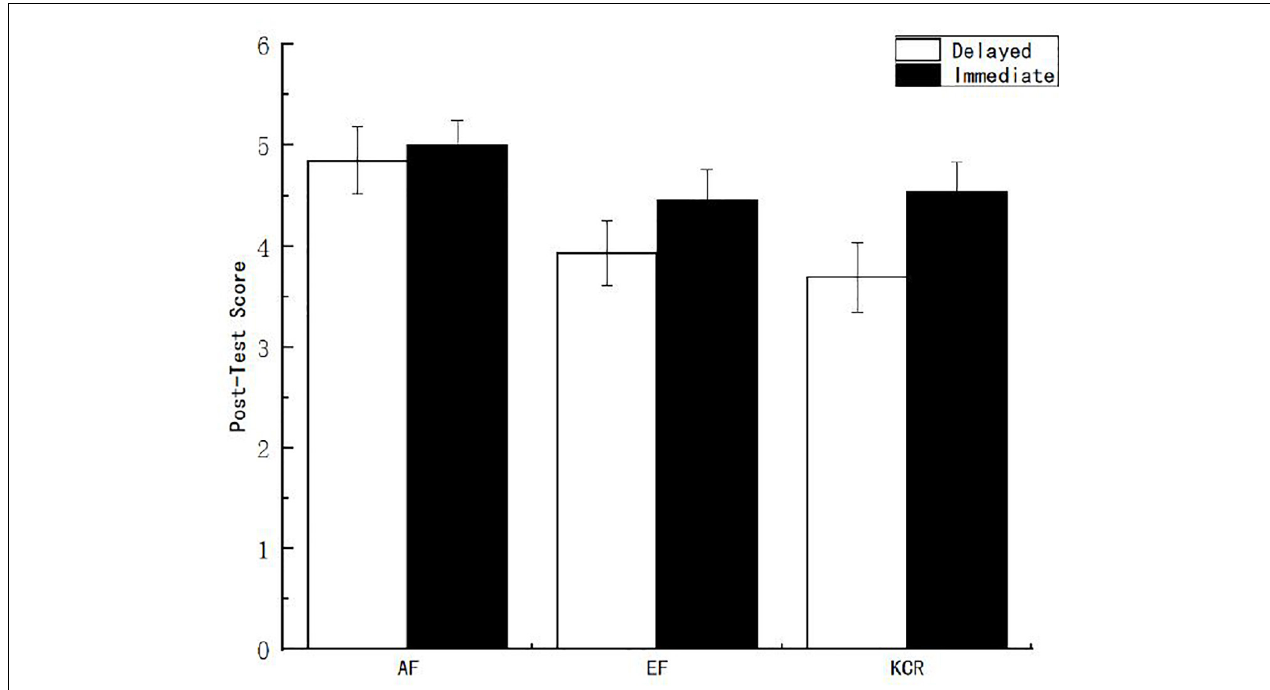
FIGURE 1 | Post-test scores of learners under different feedback conditions.